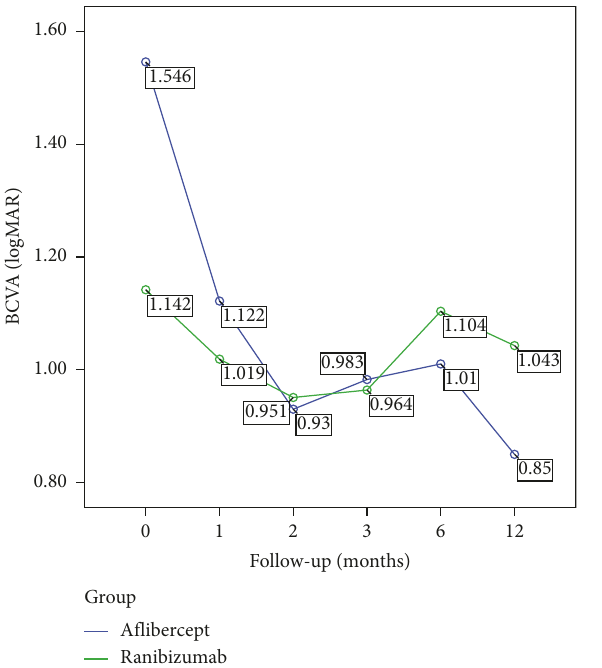
Figure 2: The CMTreduction of both groups had similar outcomes at all time points with no significant intergroup differences ( p : 0 .